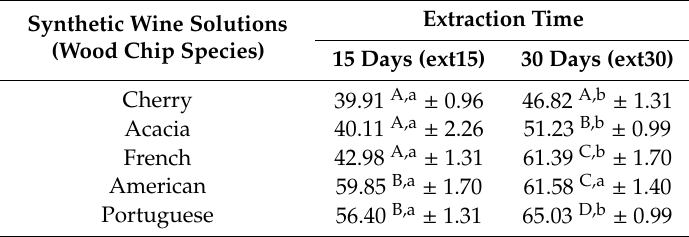
Table 3. Total phenolic content (mg / L expressed in gallic acid equivalents) quantified in synthetic wine solutions containing di ff erent wood chip species after 15 and 30 extraction days.